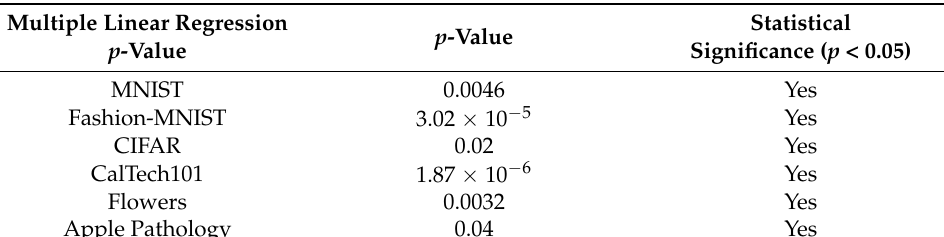
PSNR and SSIM increased with higher values of numerical aperture. For the purpose of illustrating the increased image classification accuracy due to the increase in PSNR and SSIM, the neural network activation map under different numerical apertures is pre- sented. Figure 12 shows the Google inception convolution neural network activation map and the reconstructed images corresponding to each numerical aperture. The recon- structed image on the top of Figure 12 is the input of the Google inception neural network, and the activation map is the gradient of the features learned from the neural network.